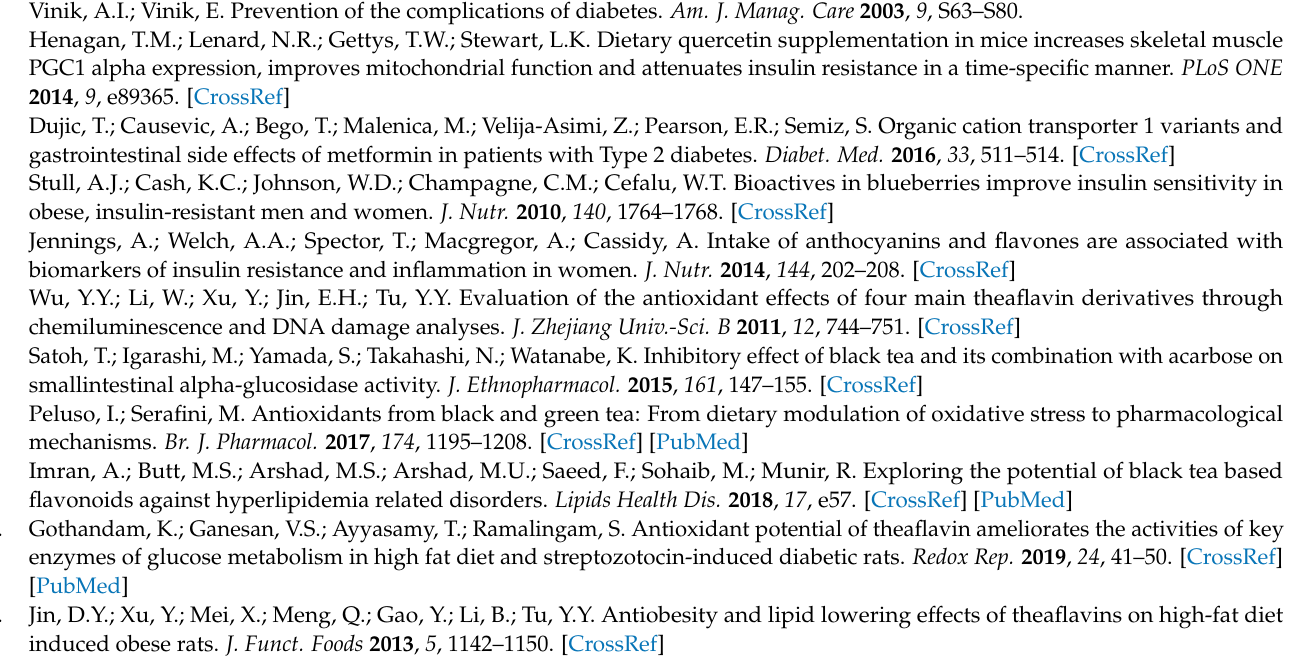
Figure S3: the effect of TF3 on zebrafish